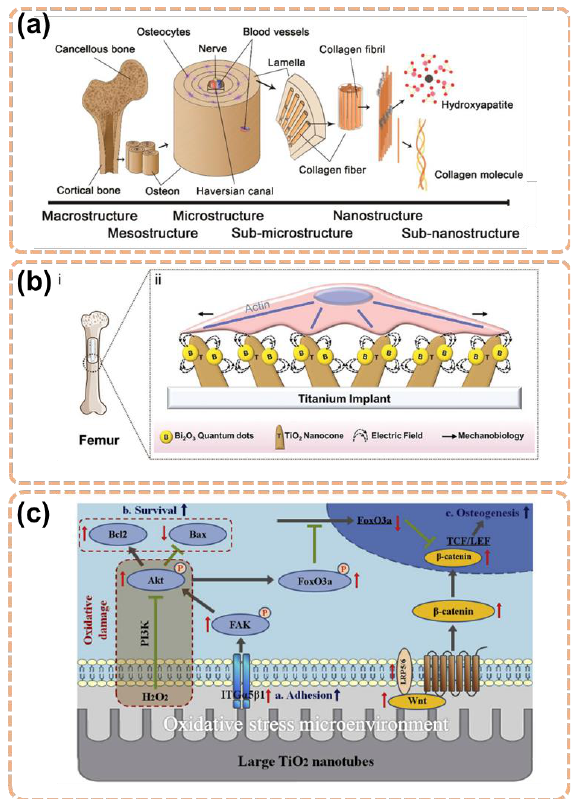
Figure 2. ( a ) The hierarchical structure of natural bone. Reprinted with permission from Ref. [31]. MDPI, 2022. ( b ) TiO 2 nanocones with Bi 2 O 3 quantum dots promotes osteogenesis. ( i ) Placing tita- nium implant in the bone defect; ( ii ) The electric field is built at the nanoscale interface of the im- plant. Reprinted with permission from Ref [30]. John Wiley and Sons, 2021. ( c ) Osteogenesis path- ways on TiO 2 nanotubes in oxidative stress microenvironment brown arrow: enhancing the expres- sion of a downstream gene; green arrow: inhibiting the expression of a downstream gene. Reprinted with permission from Ref [32]. Elsevier, 2018.